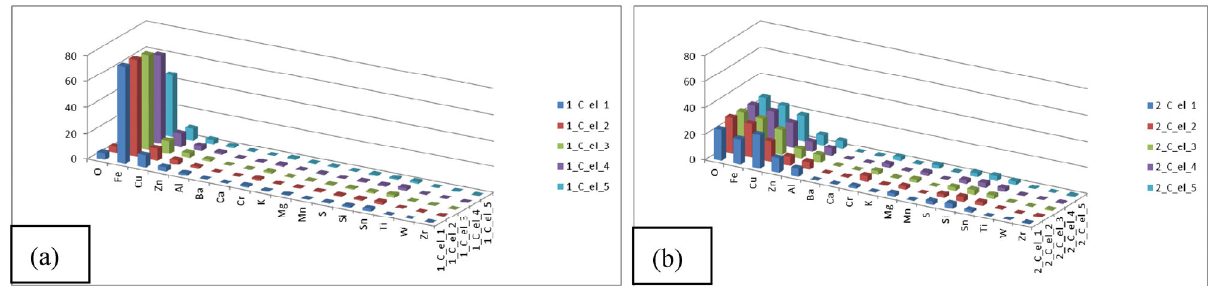
Fig. 8 Results of the five EDXS analyses carried out on spot C of the filter ELPI+ stage 12 from (a) FM4-BD1 and (b) FM4-BD2 systems. Table 4 EDXS results of fragments collected, average value between spots C and E (Fig. 4(a)) of each pad+disc couple. Pad